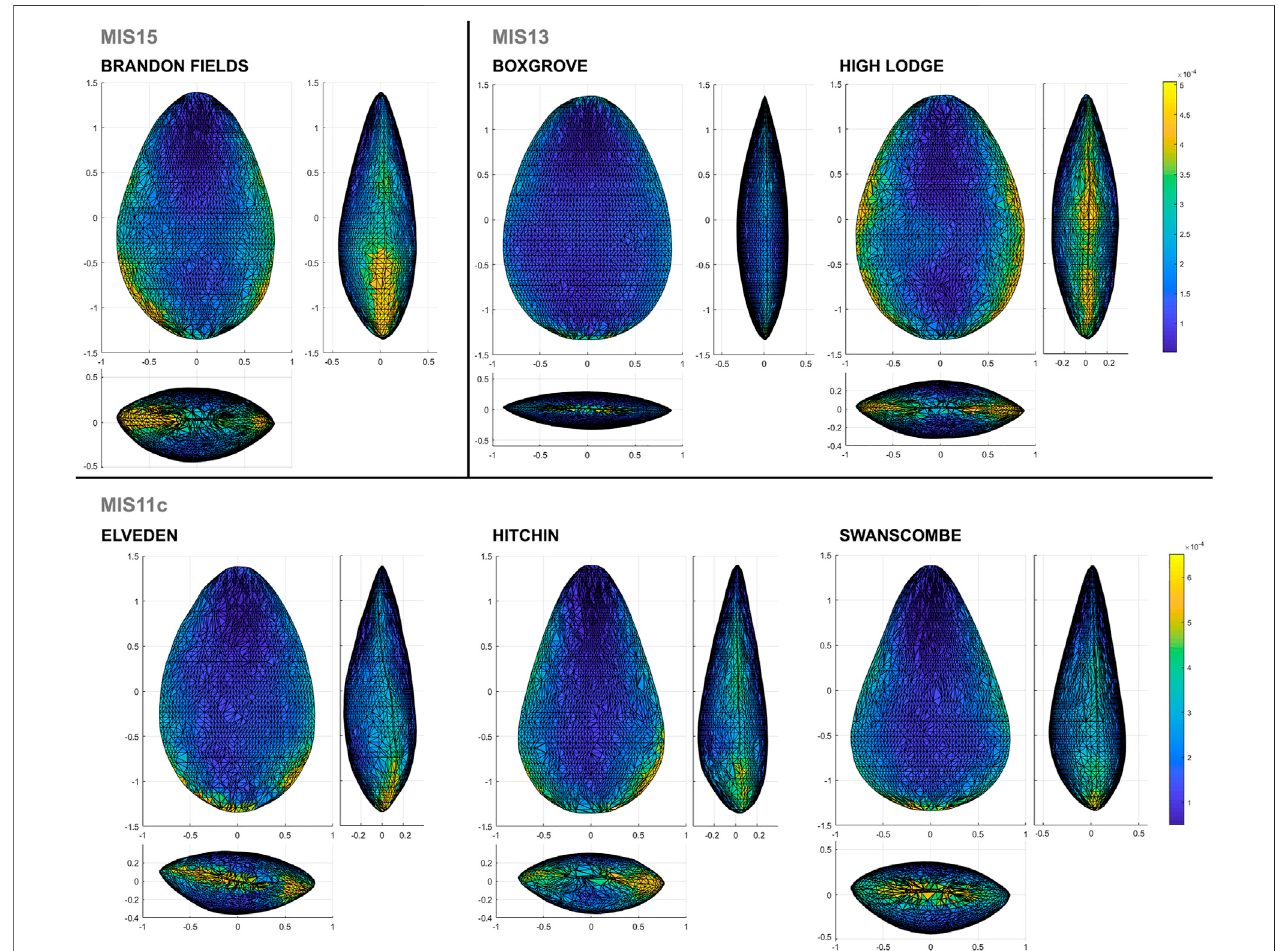
FIGURE 3 | The mean shapes of handaxes and cleavers. Color coding represents the relative degree of variability of each individual landmark re fl ecting the spatial distribution of variability across the tools.